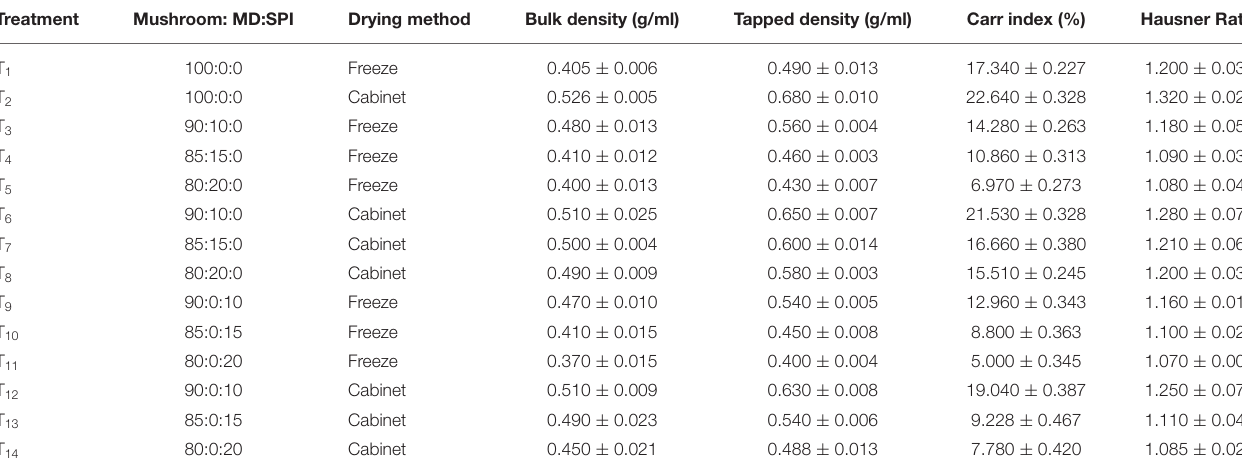
TABLE 3 | Flow properties of